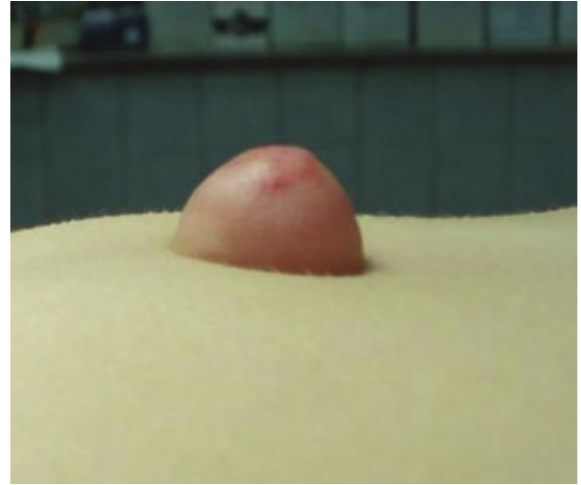
Figure 2: Clinical presentation of the incarcerated umbilical hernia (lateral view).